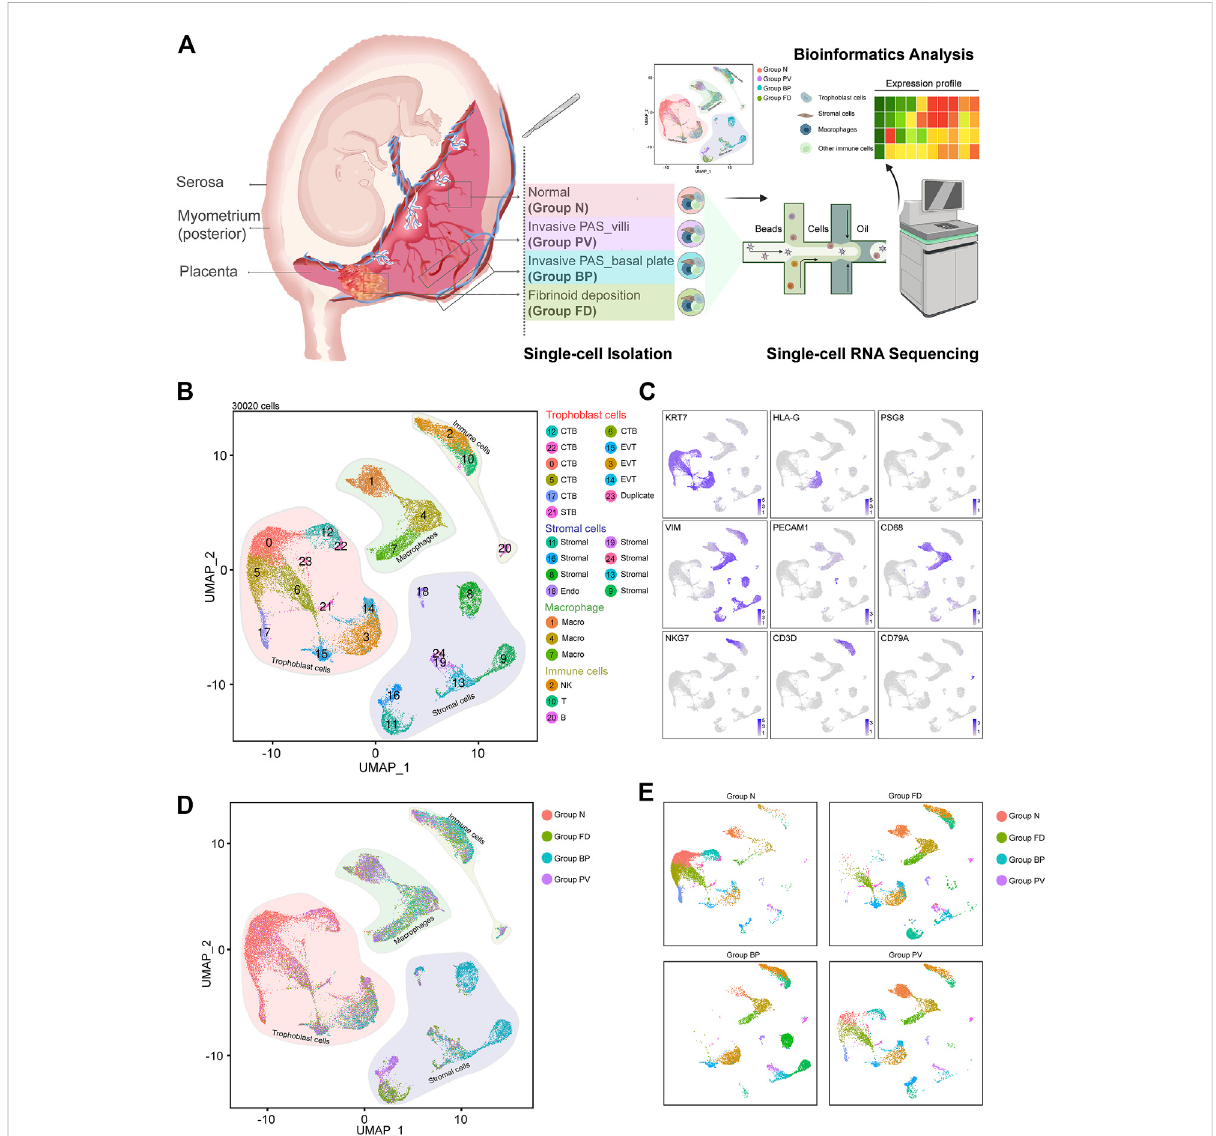
FIGURE 1 Distinguished cell clusters were classi fi ed for the placenta diagnosed as invasive PAS. (A) Schematic overview of the work fl ow of the experimental design in this study, in which four representative parts were obtained and isolated for single-cell RNA sequencing. The four parts were carefullychosenandde fi nedasGroupN(N,withvilliandbasalplateinmaternalfetalinterface),GroupFD(F,adjacent fi brinoiddeposition,frequently seen in PAS placenta), Group BP (invasive PAS_basal plate, i.e., the whole uterine wall, where the fl oating villi were deeply implanted into thin muscles, with inside, outside and sagittal views), and Group PV (dissected from the area of failure detachment of the placenta). Created with BioRender.com. (B) UMAP plot showing unbiased clustering of 193,033 cells derived from all four groups. (C) UMAP plot showing the expression of the indicated genes. (D) UMAP plot of datasets colored, and (E) the split UAMP plots by origin of each group from the invasive PAS